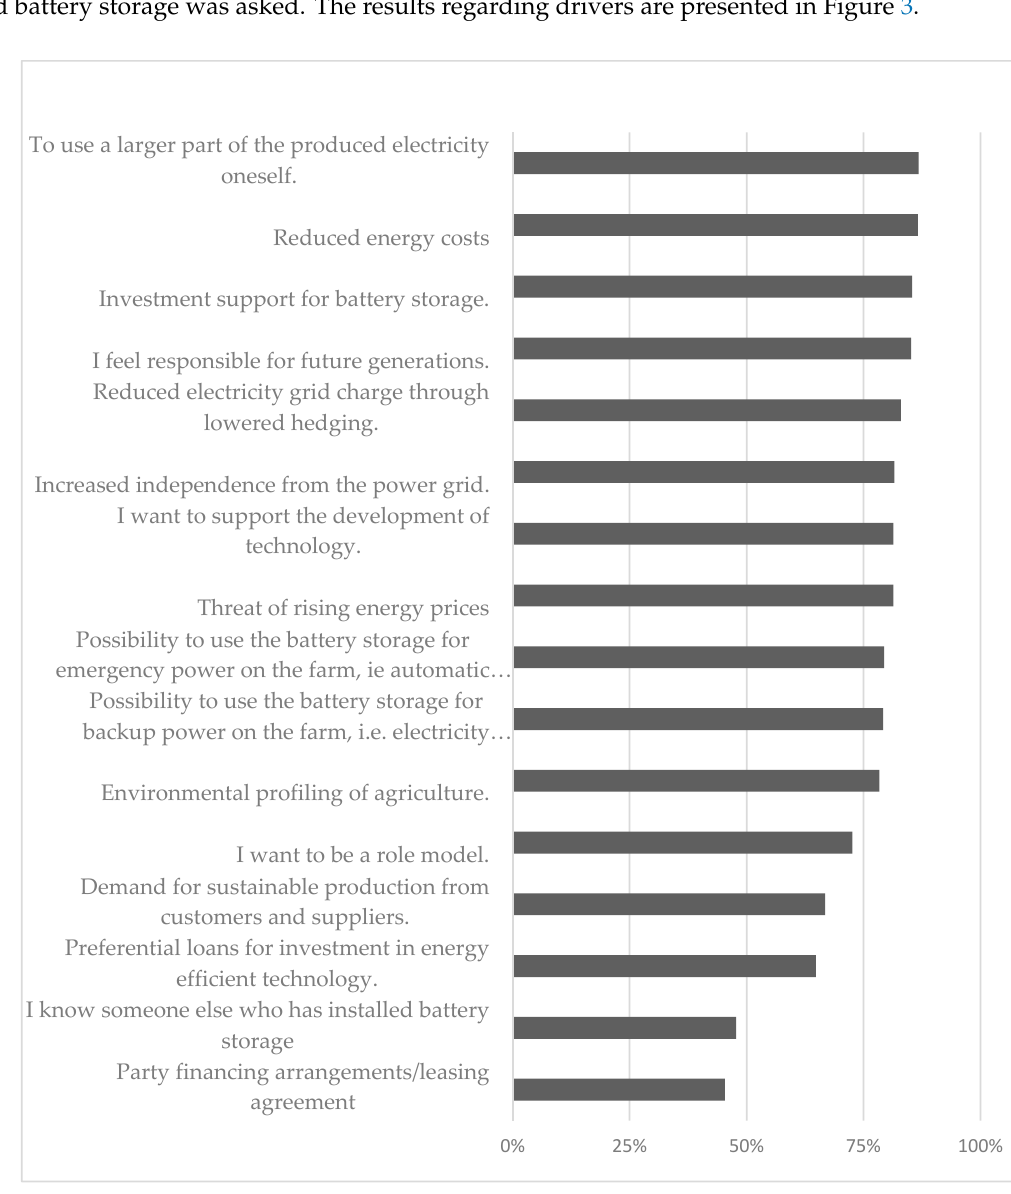
Figure 3. Major drivers to battery storage in PV systems, where 0% corresponds to a very low-ranked driver and 100% to a very high-ranked